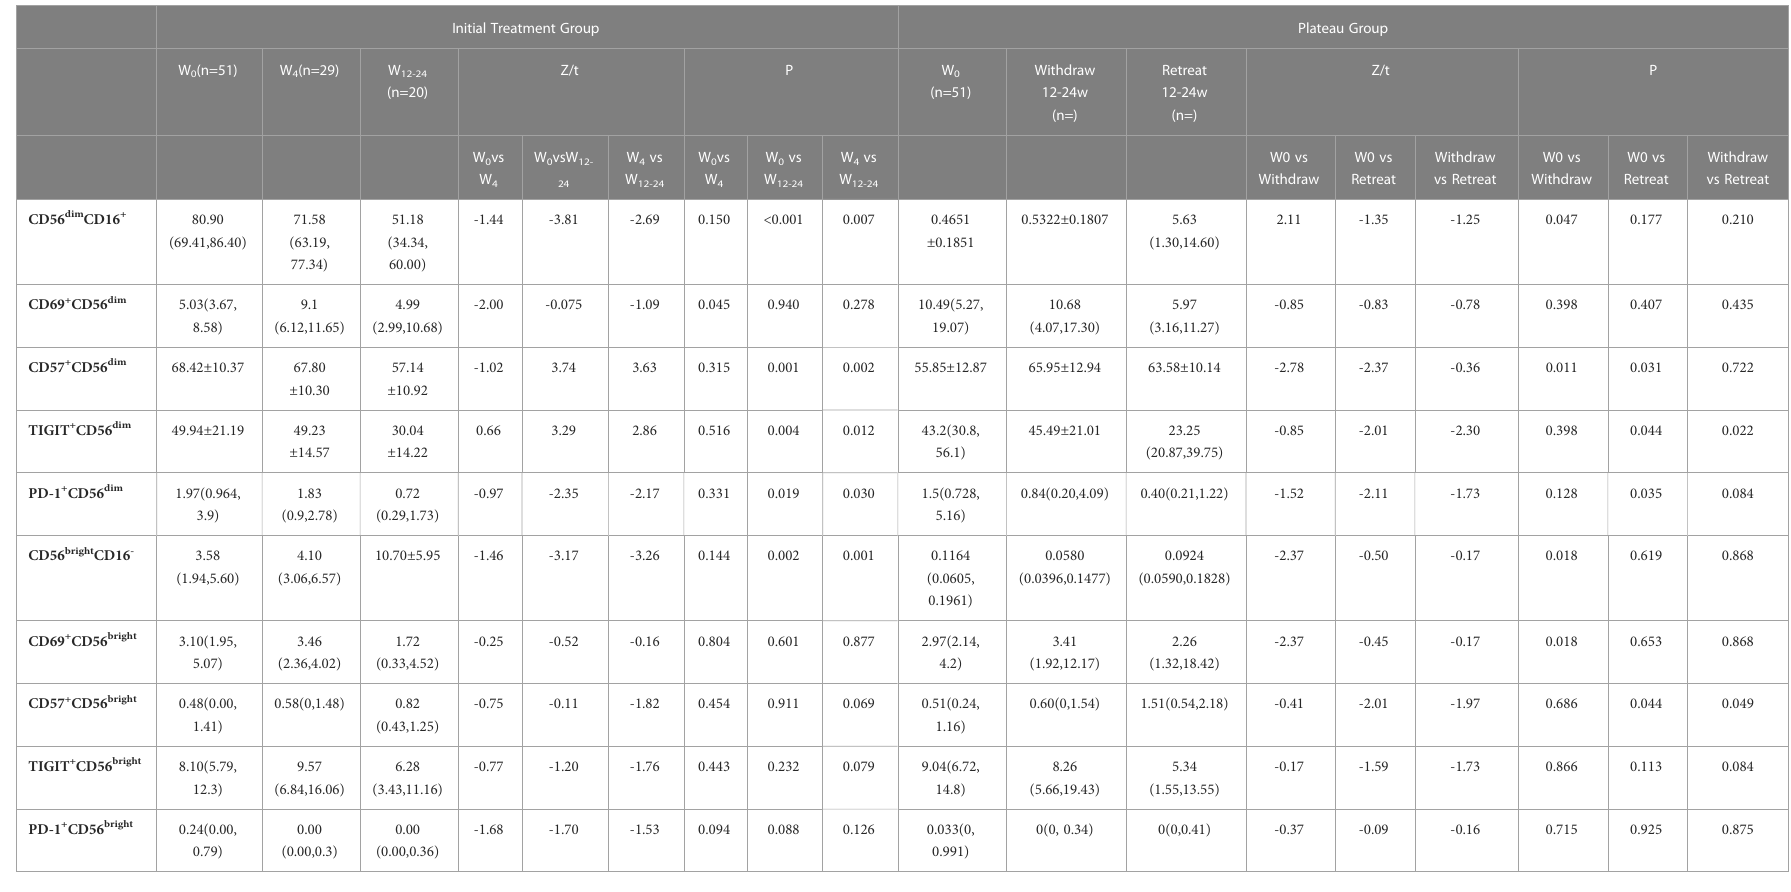
TABLE 2 Comparison of initial treatment group and plateau group during follow